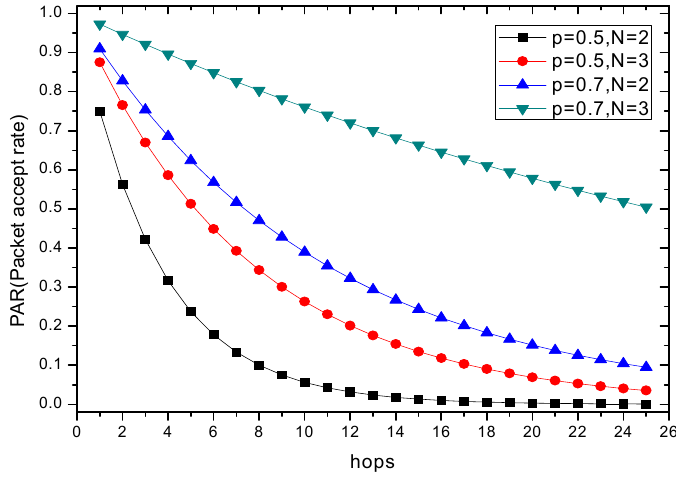
Figure 8. End-to-end reliability in opportunistic routing.